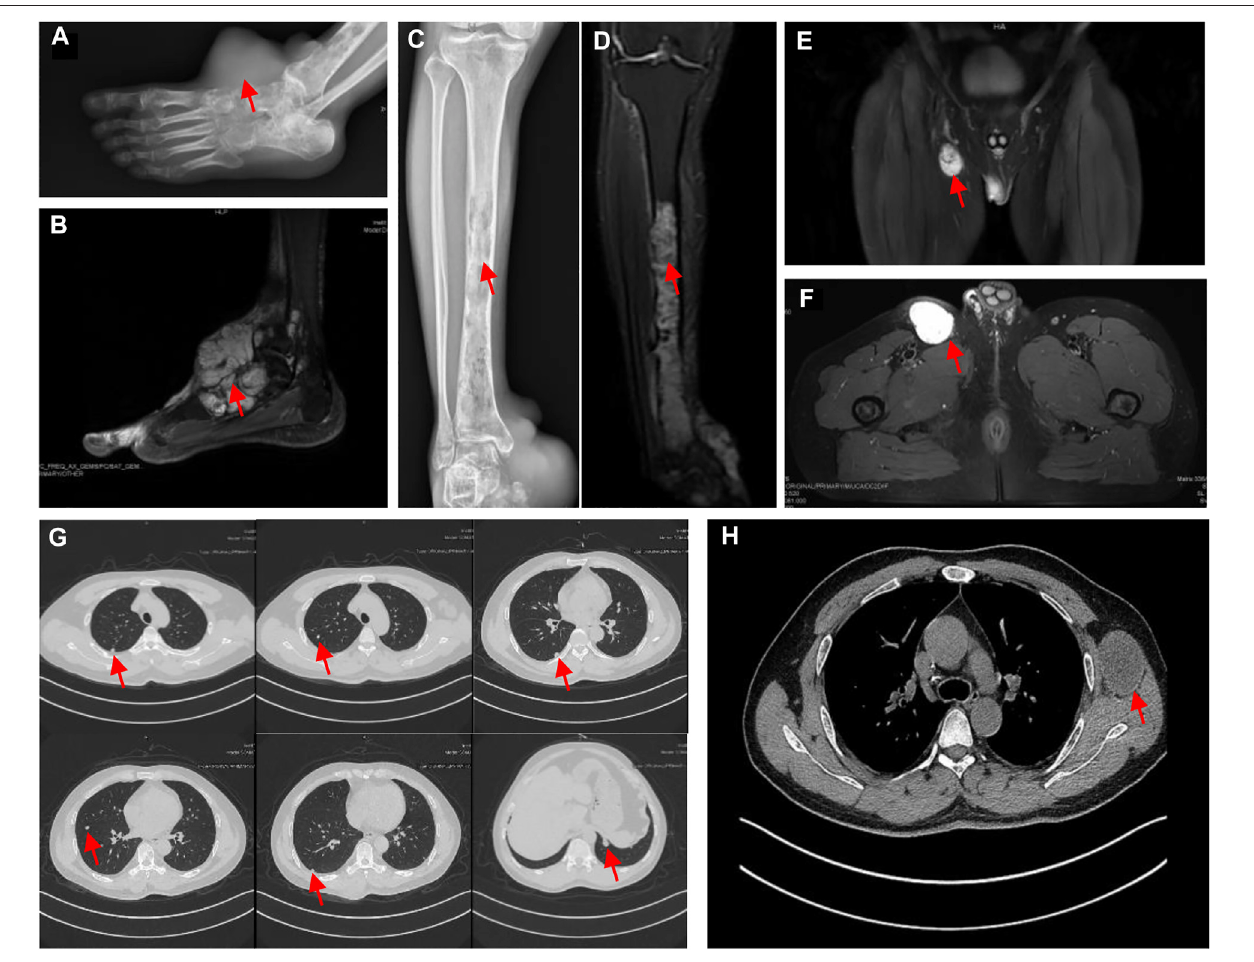
FIGURE 4 | (A) The radiograph showed an increase in size compared with Figure 1A and implication of the tarsus and talus; the radiograph revealed that pathological fracture in the middle of the right femur with a heterogeneous low signal (red arrow) in the medullary cavity. (B) T2-weighted MRI showed a heterogeneous high homogeneous signal in T2WI with a clear border. (C) and (D) the X-ray and MRI revealed the metastasis in the tibia and fi bula. Consecutive bone destruction was seeninthemiddleandlowersegmentofthetibiaandthedistal fi bula. (E) and (F) TheMRI(coronalandtransversesections)displayedthemetastasisinrightinguinal lymph nodes (G) CT scan of the chest showed the pulmonary metastasis. (H) CT showed the left axillary lymph node